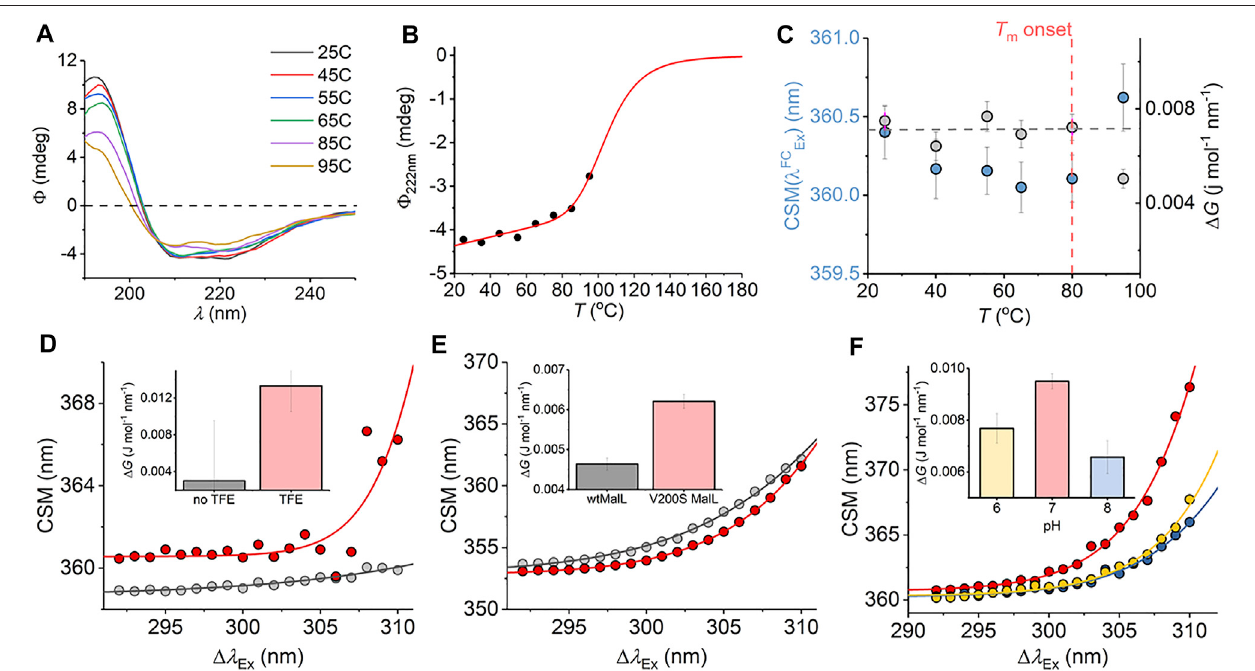
FIGURE 6 | (A – C) Temperature dependence of the ss GDH REES effect and correlation with unfolding. (A) Temperature dependence of far-UV CD spectra. (B) Temperature dependence of Φ 222nm . Solid line is the fi t to Eq. (8) as described in the main text. (C) Temperature dependence of parameters extracted from fi tting the ss GDH REES data to Eq. (7) (D – F) REES effect of C45 in the presence and absence of TFE, raw data as Ref. 17 (D) ; wt MalL and V200S MalL, raw data as Ref. 16 (E) ; and ss GDH at different pH values (F) . The inset bar charts (D – F) show the magnitude of Δ G extract from fi tting to Eq. (7) .